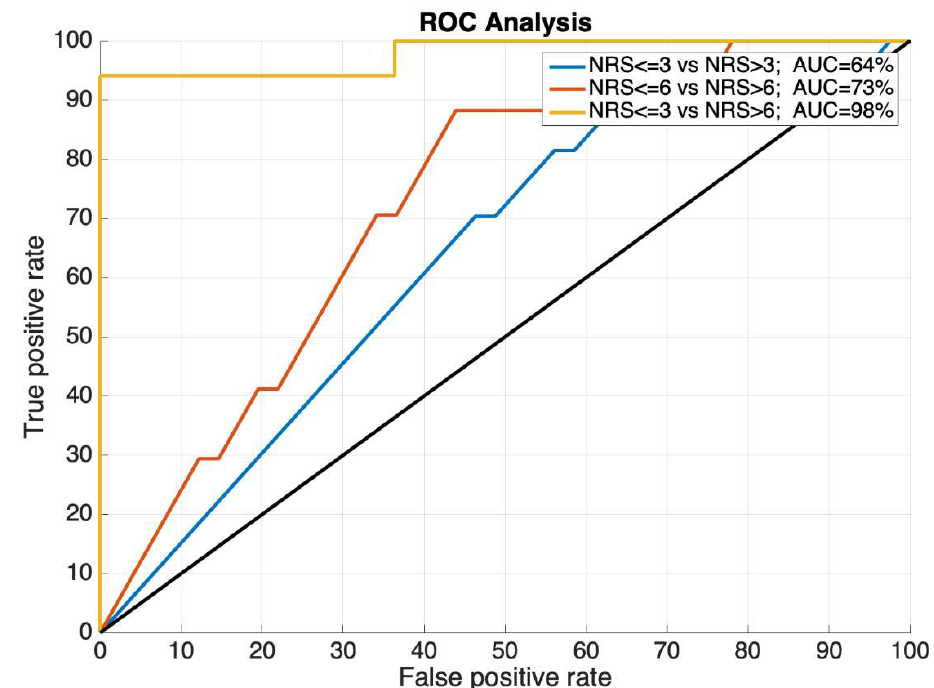
Figure 4. Baseline period receiver operating curves for the numeric rating scale (NRS) ≤ 3 and NRS > 3 (blue line, AUC = 64%); NRS ≤ 6 and NRS > 6 (orange line, AUC = 73%); and NRS ≤ 3 and NRS > 6 (yellow line, AUC = 98%). AUC values, used as a performance indicator, were excellent (AUC > 90%).